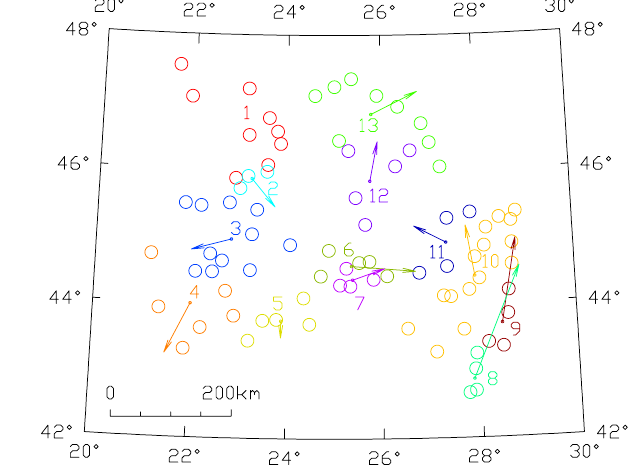
Figure 6. Simulated example: transformation units and relative shifts with respect to E1.